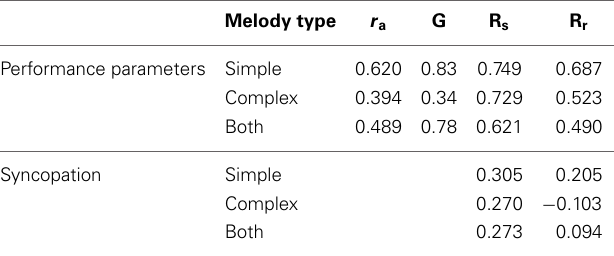
Table 3 | Lens model factors for the same performance parameters as in Table 2, for simple, complex, and both types of